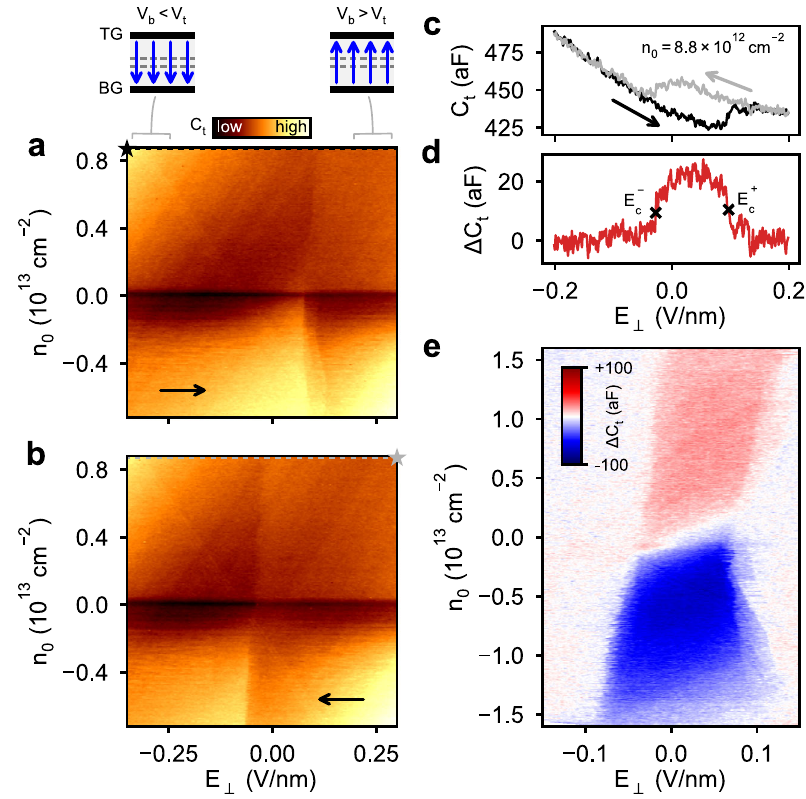
Fig. 2 Hysteresis in the electric fi eld response for electrons and holes. a Forward and b backward scans of the top capacitance C t as a function of electric fi eld, E ⊥ , for a range of carrier densities, n ⋆ symbol in each case) 0 . c Capacitance traces measured along the dashed lines in a , b (beginning at the displaying a smooth background as well as sudden jumps at electric fi eld values that depend on the sweep direction. d Difference between the traces in c . e Compilation of differences between forward and backward scans in a , b for an extended range of carrier densities, showing the change in sign of the switching from electrons to holes and the gradual density dependence of the switching